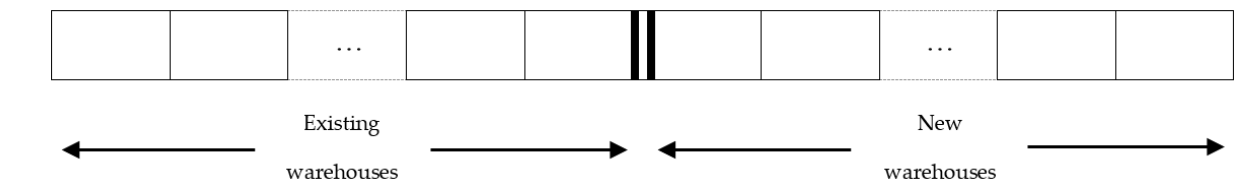
Figure 2. Structure of chromosomes in the proposed algorithm for SSCNR.